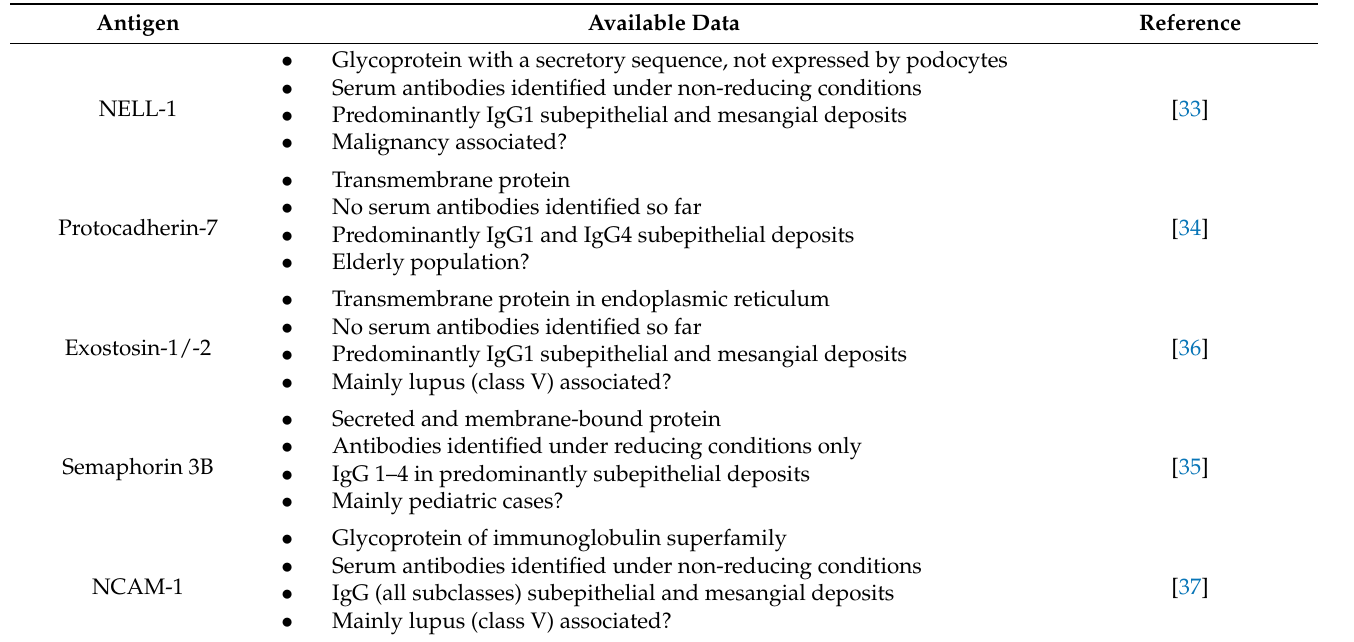
Table 3. Recently reported antigens in MN requiring further validation. Available